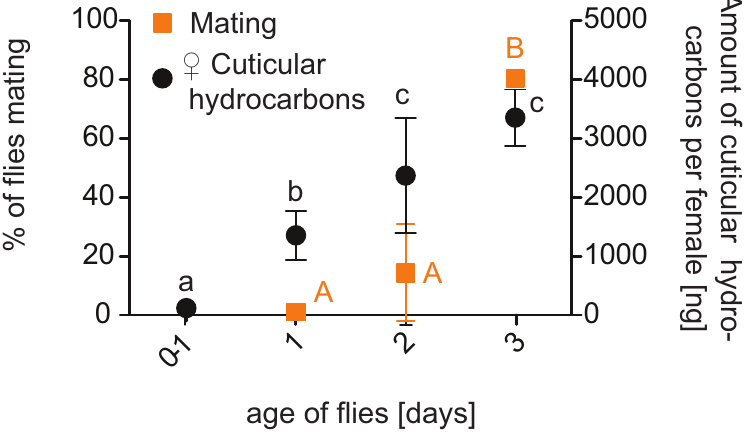
Figure 3. Mean percentage of mating activity of 1 – 3-day-old virgin flies (orange square) and development of female cuticular hydrocarbons (black circles) during 3 days after eclosion. Tested during 1 h of the main mating period (starting instantly after lights went on), virgin flies significantly increased their mating activity on the third day after emergence (different capital letters indicate significant differnce, Tukey’s test following ANOVA; p < 0.05, mean ± SEM). The total amount of female CHCs showed a significant increase over time (different lowercase letters indicate significant differnce Tukey’s test following GLM, p < 0.05, mean ±